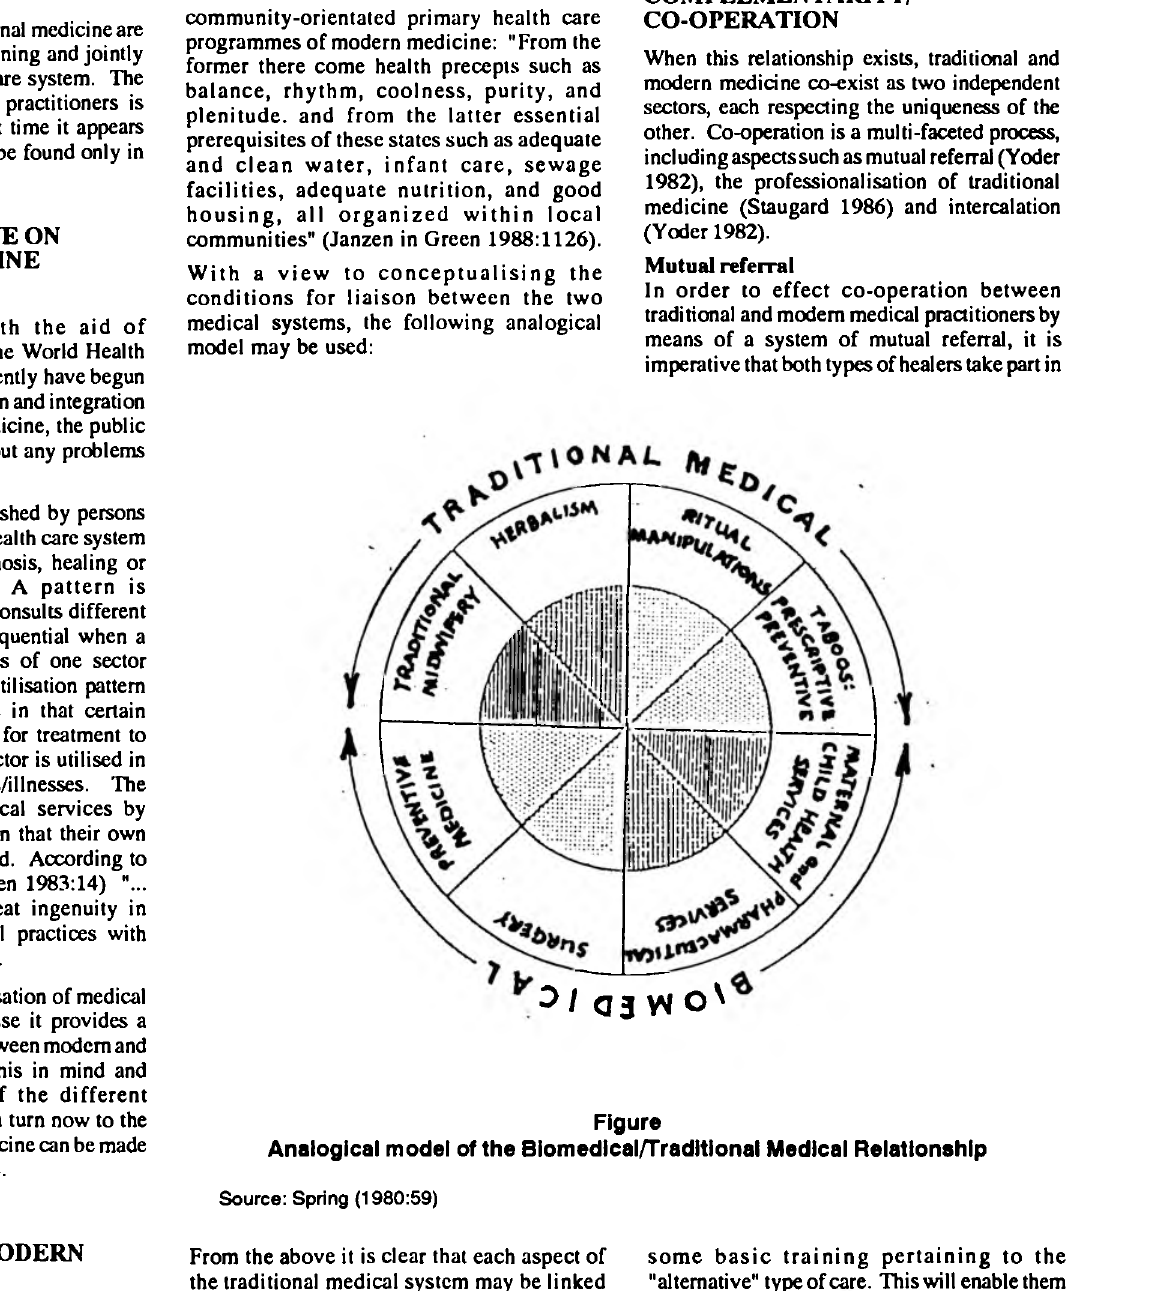
Analogical model of the Biomedical/Traditional Medical